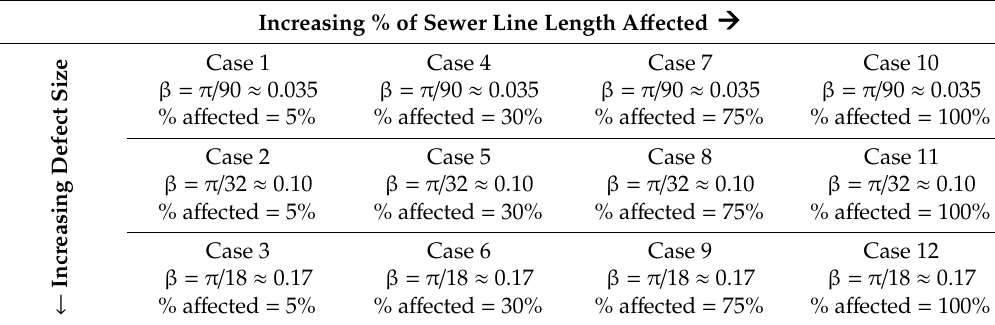
Table 6. Defect severity cases for pipes newly submerged due to SLR. Increasing % of Sewer Line Length A ff ected